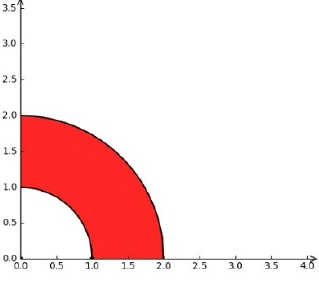
) . Figure 3. The area of 1